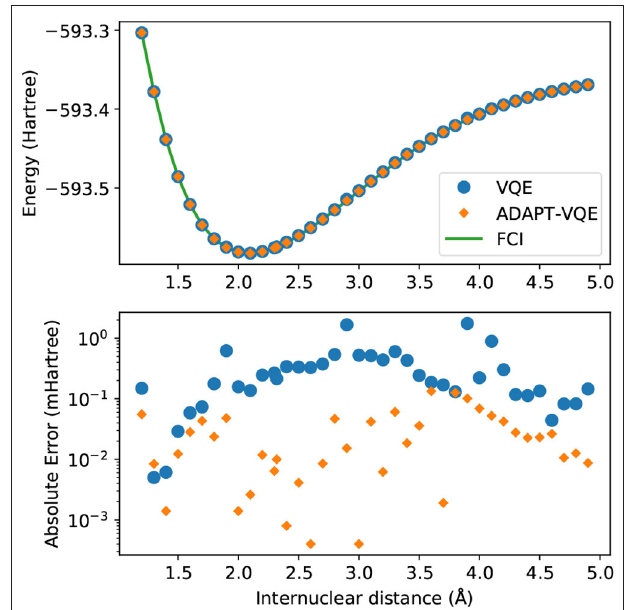
FIGURE 2 | (Top) Potential energy curves of NaH computed with the STO-3G basis set for FCI (green solid line), VQE (blue circles), and ADAPT-VQE (orange diamonds) with the COBYLA optimizer. (Bottom) Absolute error in the minimized energy for VQE (blue) and ADAPT-VQE (orange) relative to the FCI reference value.